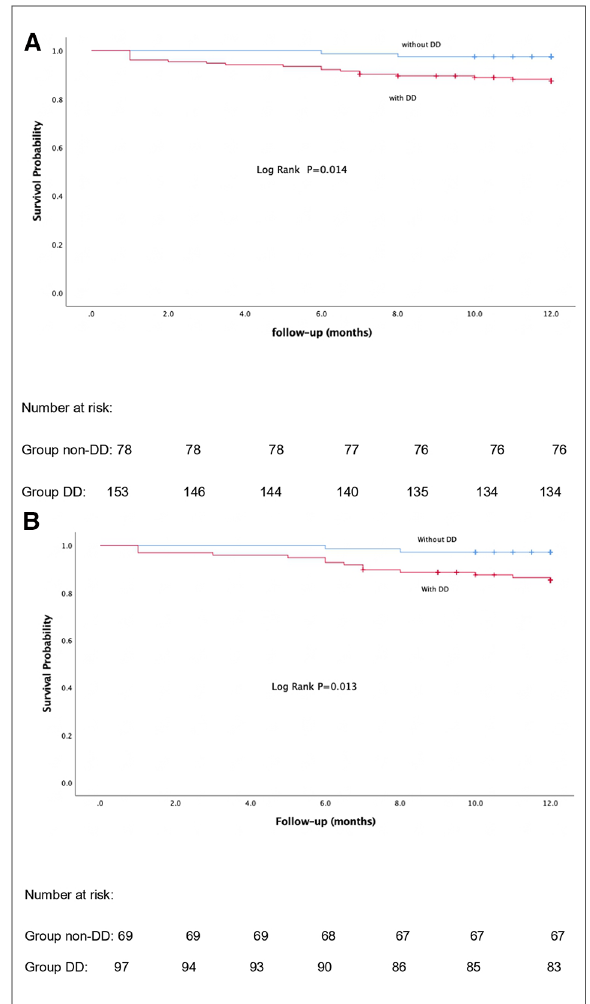
FIGURE 2 Kaplan-Meier curves of 1-year mortality post-LT before and after propensity score matching analysis. ( A ) Before-PSM. ( B ) After-PSM. P -value<0.05 was regarded as statistically signi fi